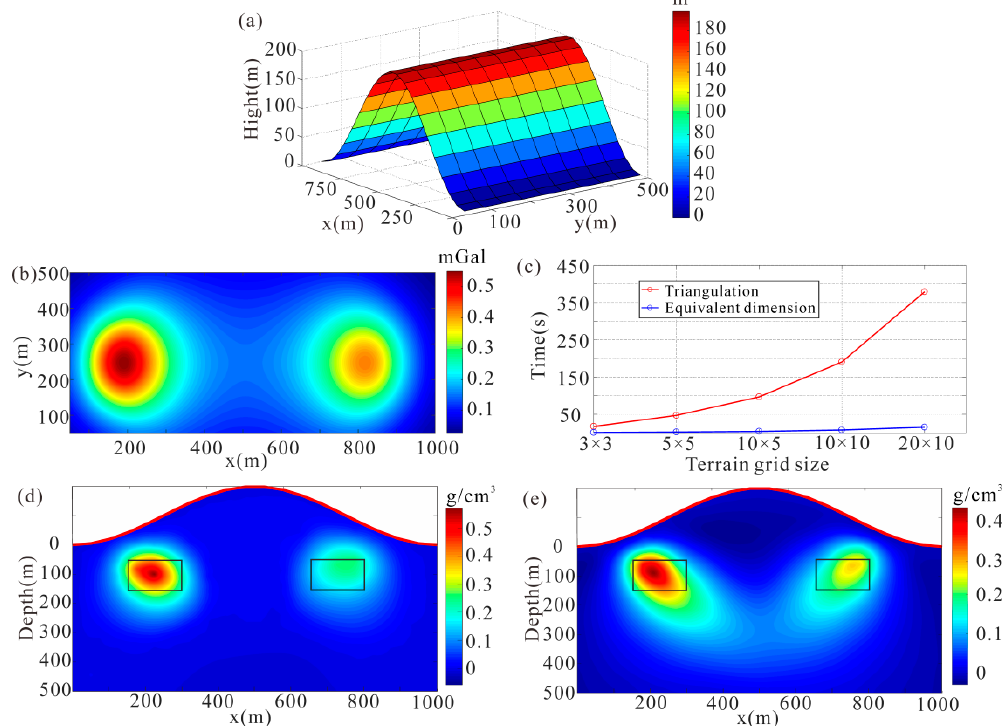
Figure 3. Gravity inversion by the preconditioned JFNK method. ( a ) Surface topography; ( b ) gravity anomalies under undulating terrain; ( c ) comparison of mesh computing time; ( d ) slice at y = 250 m of inversion result with equivalent-dimensional meshes; ( e ) slice at y = 250 m of inversion result with triangulation mesh.